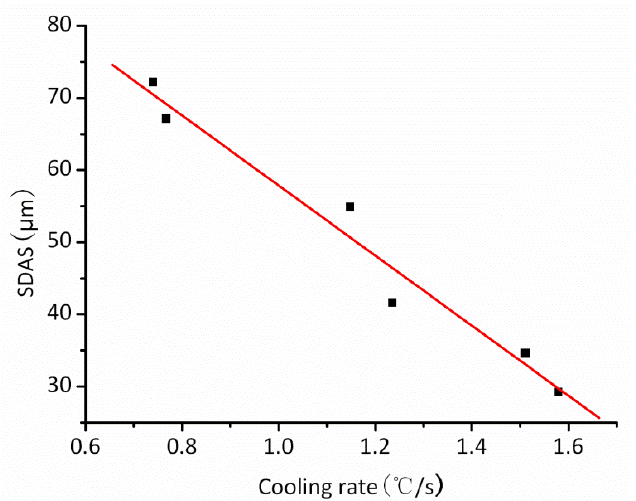
Figure 10. The relation between SDAS and cooling